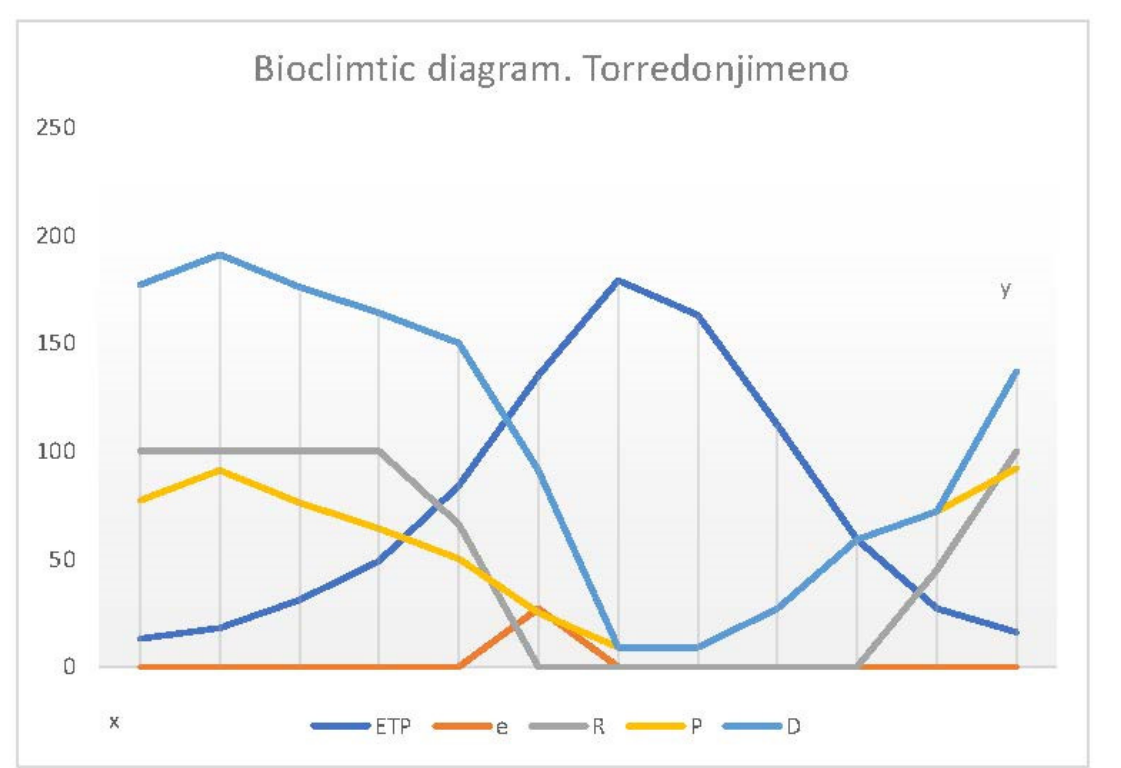
Figure 7. Bioclimatic diagram for Torredonjimeno: P = precipitation, ETP = potential evapotranspiration, D = water availability, R = soil water reserve, e = residual evapotranspiration (mm. water).